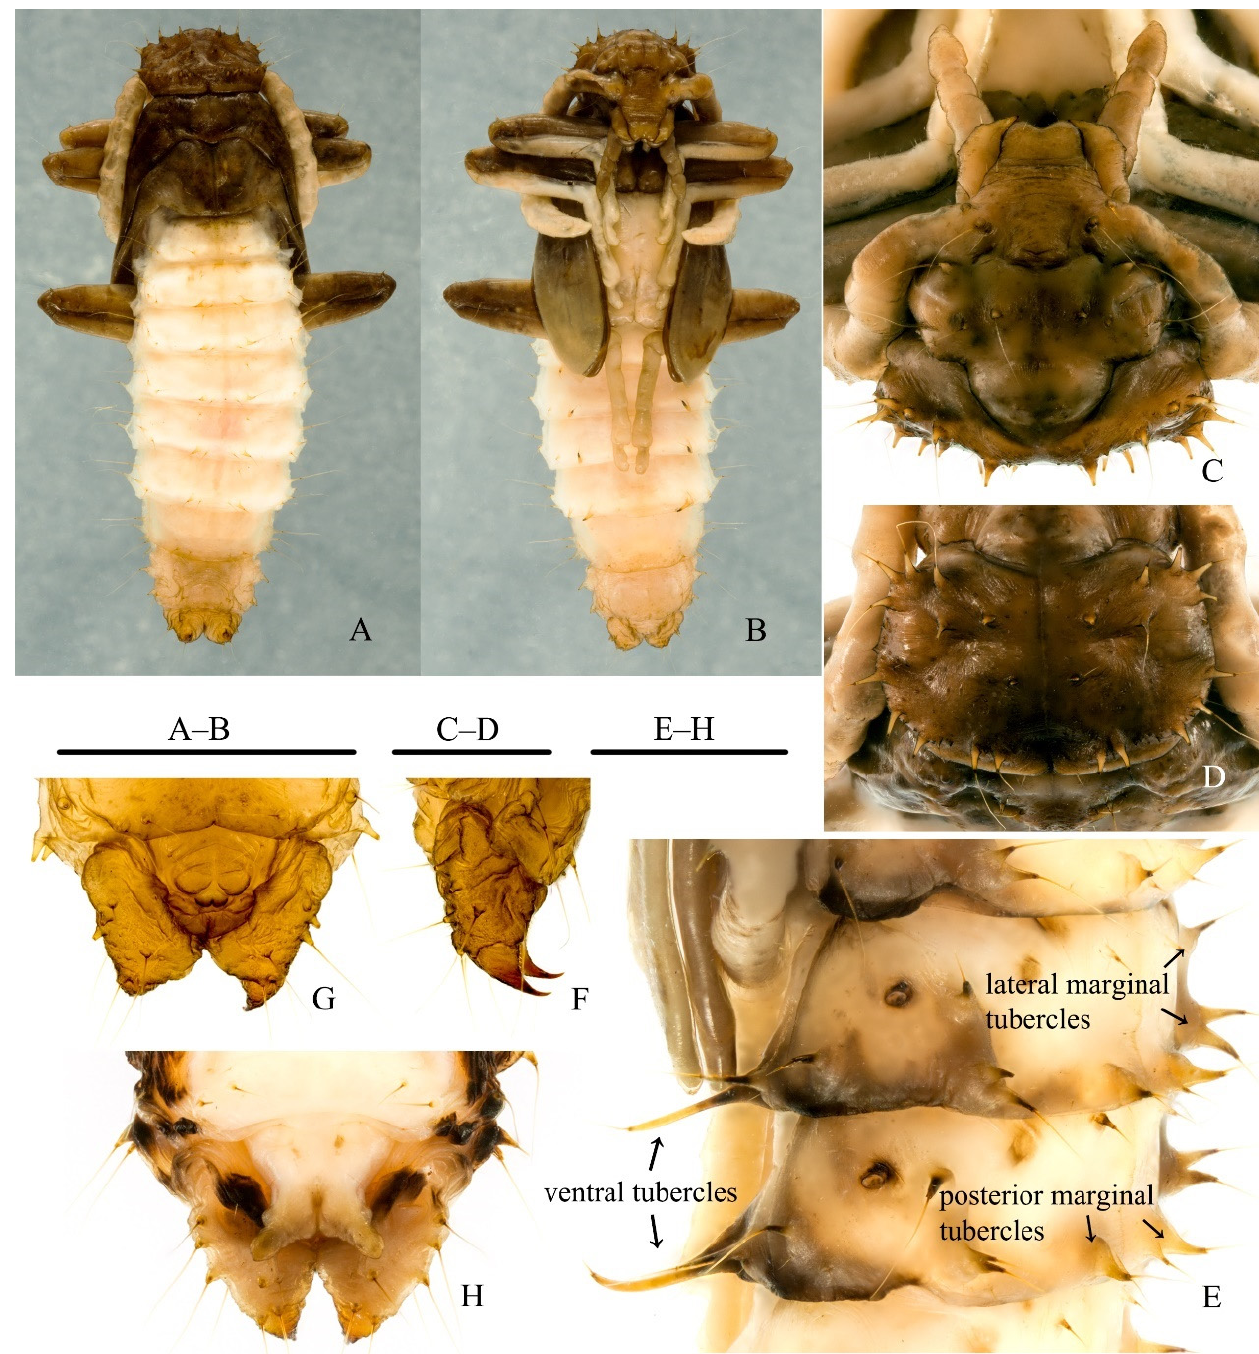
Figure 6. Pupa of Pseudopyrochroa reni Pan & Young, n. sp. ( A , B ) Habitus, male: ( A ) dorsal view, ( B ) ventral view; ( C ) Head, male; ( D ) Pronotum, male; ( E ) Abdominal segments III–IV, female, dorsolateral view; ( F ) Urogomphi, male, lateral view; ( G ) Sternite IX and male genitalia, ventral view; ( H ) Sternite IX and female ovipositor, ventral view. Scale bars: 5 mm ( A , B ), 1 mm ( C – H ). Spiracles: Abdominal spiracles (Figure 6E) located on dorsolateral margin of ab- dominal tergites I-VI, paired, ovate, larger on I than that on II-VI. Female . Length 10.3–13.4 mm, abdominal width 3.1–4.1 mm (n = 10). Depressions on head distinctly shallower than those in male. Posterior margin of tergite VII rounded in middle, and that of sternite VII widely rounded. Ovipositor as in Figure 6H.